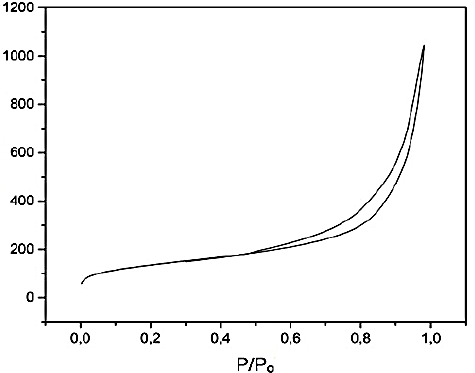
Figure 4. Nitrogen Adsorption Isotherm for the Bimodal Silica (obtained at 77 K).